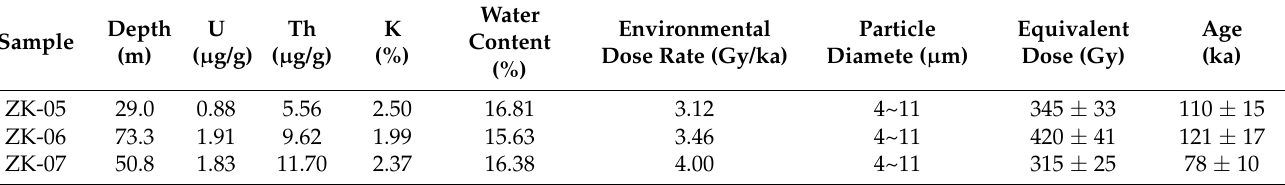
Table 1. OSL dating parameters and test results of